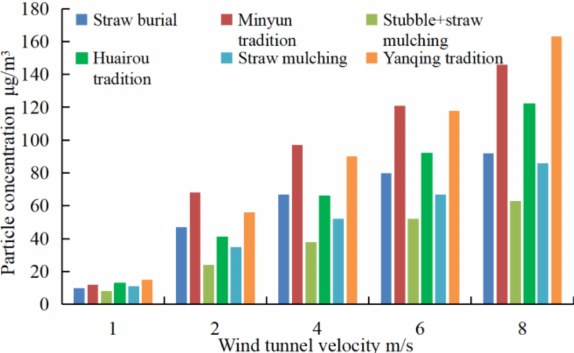
Figure 22. Changes of PM10 concentrations at 10 cm height under different wind speeds.